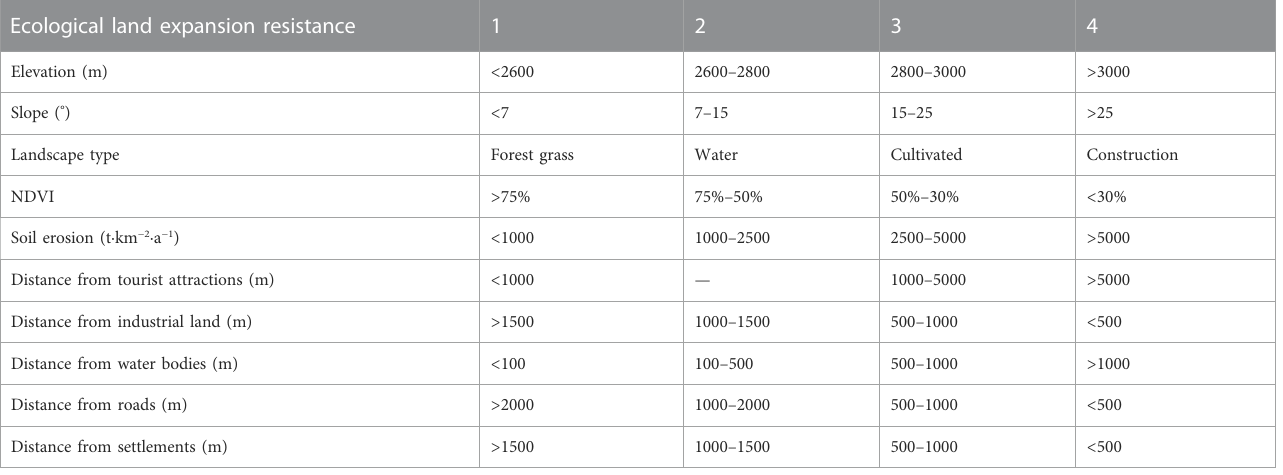
TABLE 2 Value system for ecological resistance factors.